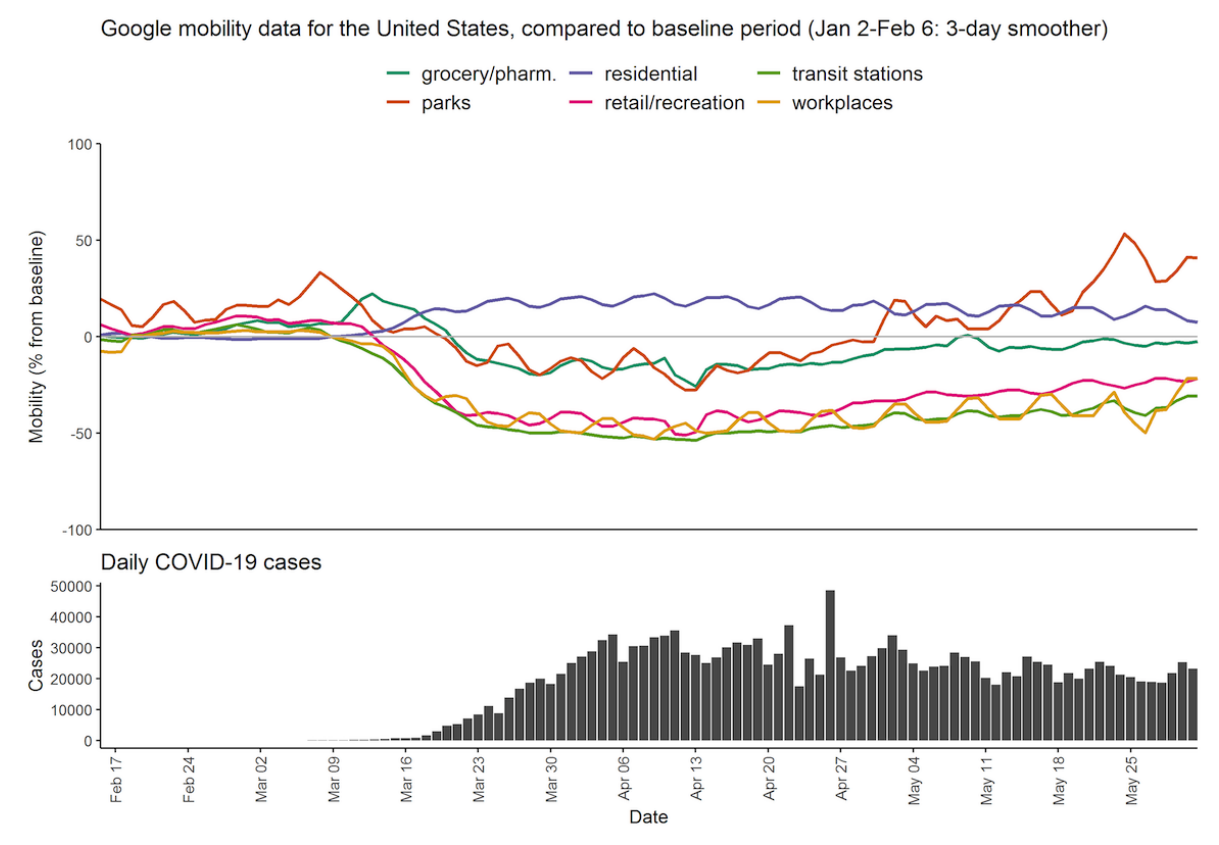
Figure 2. Mobility and case counts for the United States from February 15 to May 31, 2020. Google mobility data is only available since February 15. pharm.: